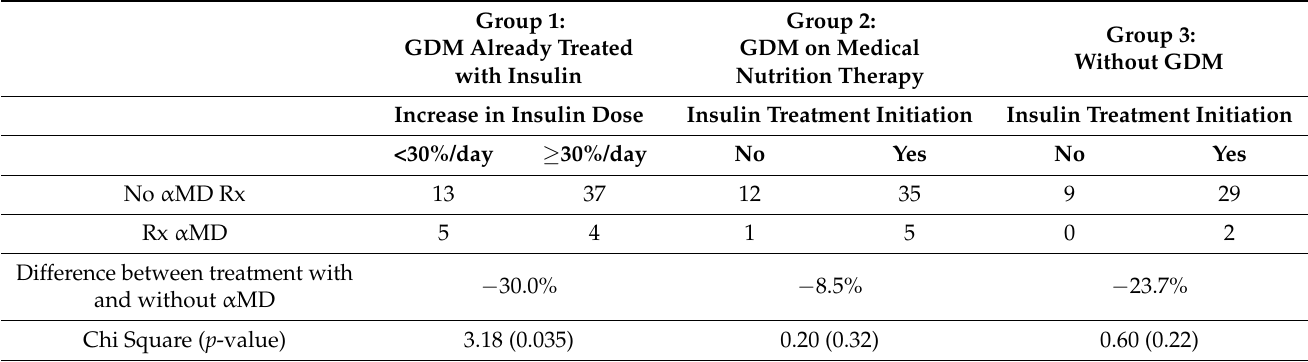
Table 1. Insulin demand after administration of GCs in